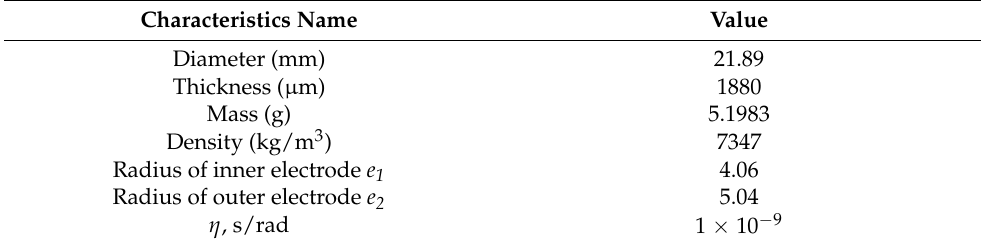
Table 1. Measured characteristics of the